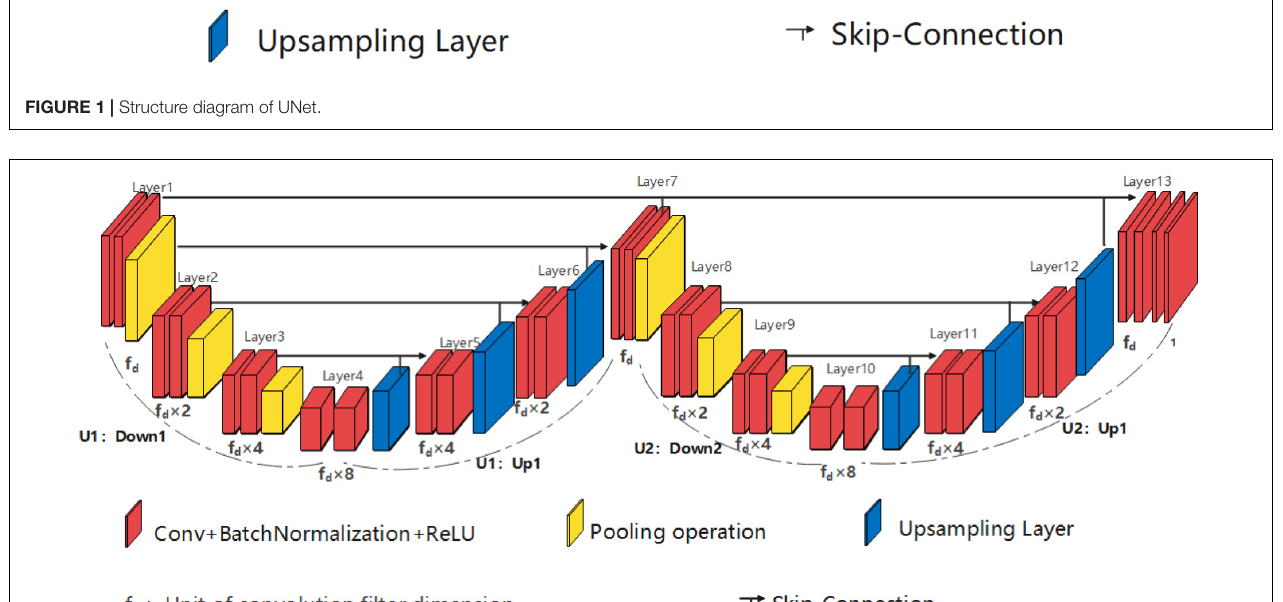
FIGURE 2 | Structure diagram of single high peak horizontal EUNet (SHP-horizontal EUNet) U 1 (4-4)-U 2